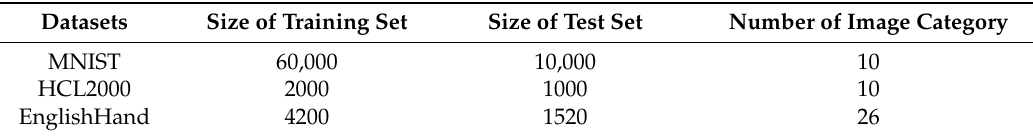
Table 1. Test and training datasets.